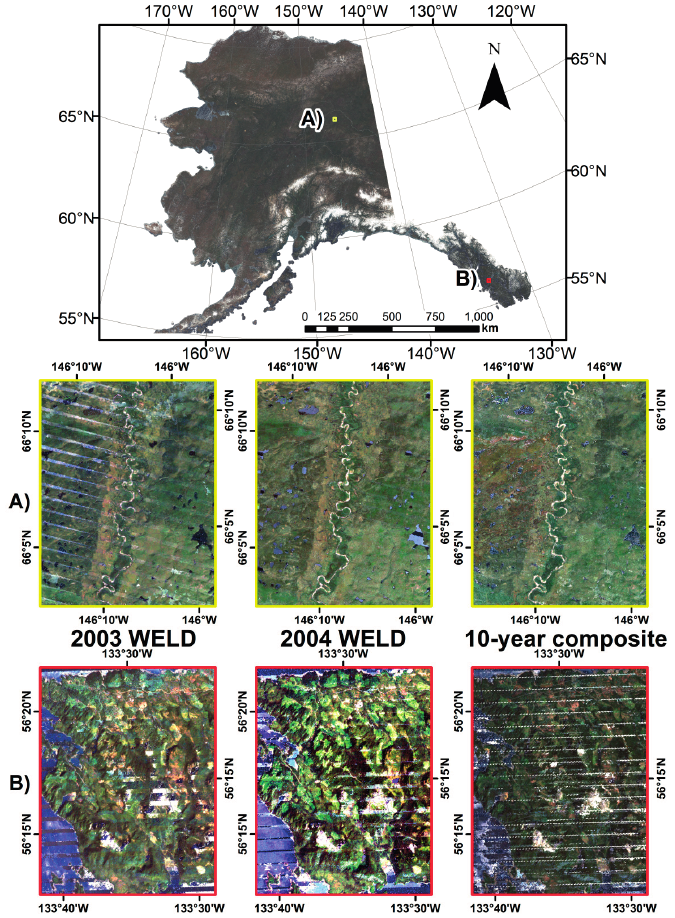
Figure 3. Alaska WELD super-composite with insets ( A ) showing an area where noticeable artifact is visible in the individual annual composites but substantially reduced in the super-composite, and ( B ) showing an area where substantial artifact remains in the